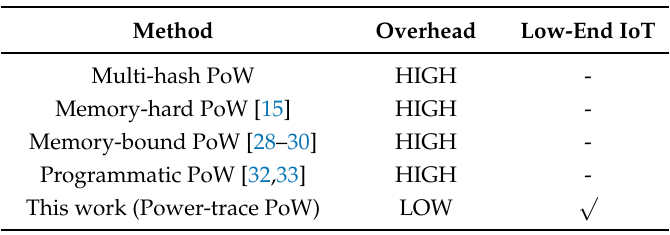
Table 2. Comparison of the PoW